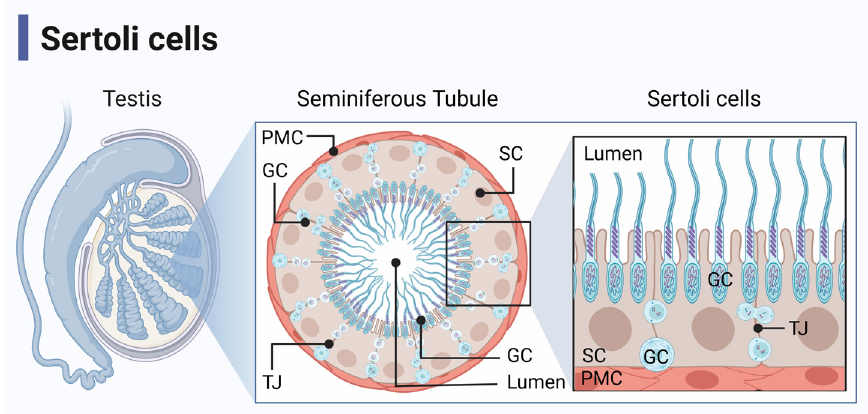
Figure 1. Seminiferous tubule anatomy. Sertoli cells (SC) and germ cells (GC) are located in the seminiferous tubules of the testis, which are surrounded by peritubular myoid cells (PMC). SC function to nurture spermatogenesis and protect GC from immune responses. They make up the blood–testis barrier by forming tight junctions (TJ) with adjacent SC. Figure created with BioRender accessed on 1 December 2022.